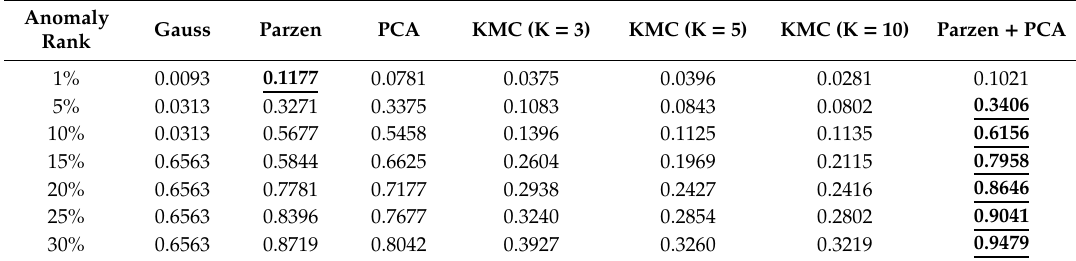
Table 12. True detection rate of each anomaly detection algorithm based on the daily activity summary dataset (Salesman). Best performance is shown in bold and underlined (number of normal behaviors in the test set: 14,120, number of malicious behaviors in the test set: